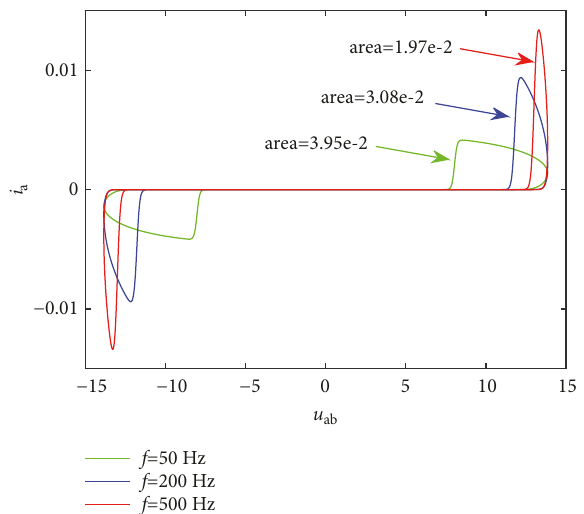
Figure 10: Curves of input voltage 𝑢 ab and input current 𝑖 a .